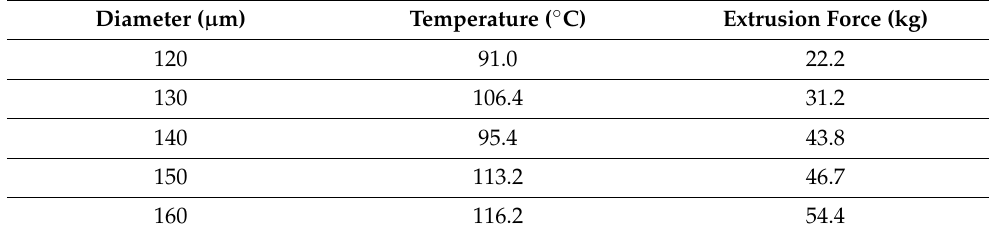
Table 3. Process parameters of extrusion 3D